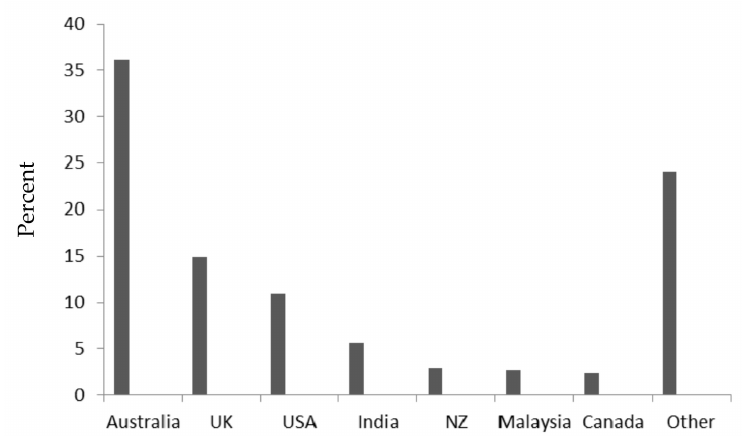
Figure 1. Countries accessing the Bronchiectasis Toolbox. UK—United Kingdom, USA—United States of America, NZ—New